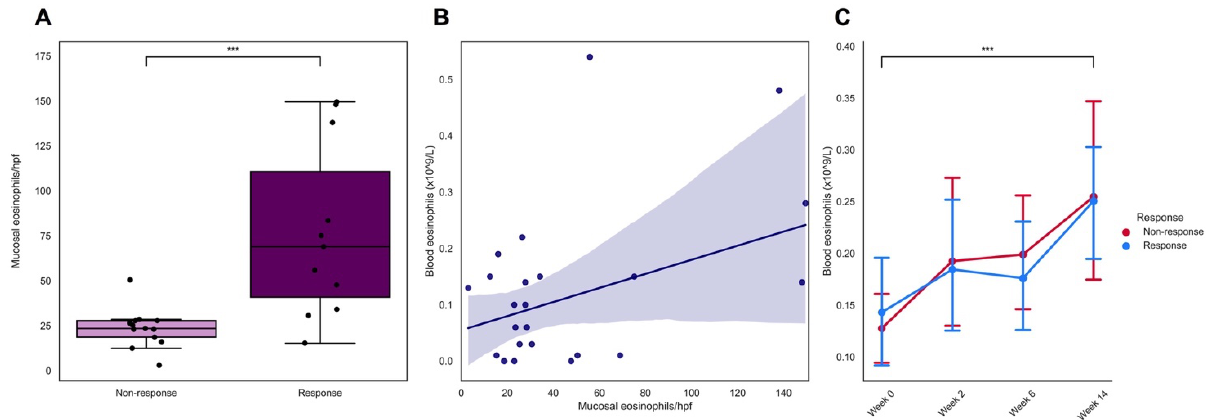
Figure 1. ( A – C ). Mucosal eosinophil abundance associates with clinical response to vedolizumab induction therapy in the discovery cohort. ( A ) Median eosinophils/hpf were significantly higher among patients who eventually responded to vedolizumab induction therapy vs. patients who showed no response. ( B ) Mucosal eosinophil counts were significantly associated to blood eosinophil concentrations. The blue line was fitted using a robust regression method by minimizing least trimmed squares (LTS), which is not unduly affected by outliers. The blue shade represents the 95% confidence interval (CI). ( C ) Blood eosinophil concentrations significantly increased after vedolizumab induction therapy. *** p < 0.001. Abbreviations: hpf, high power Table 2. Univariable logistic regression analysis of predictors of clinical response or remission to vedolizumab induction therapy at week 14 in patients with IBD included in the discovery cohort.